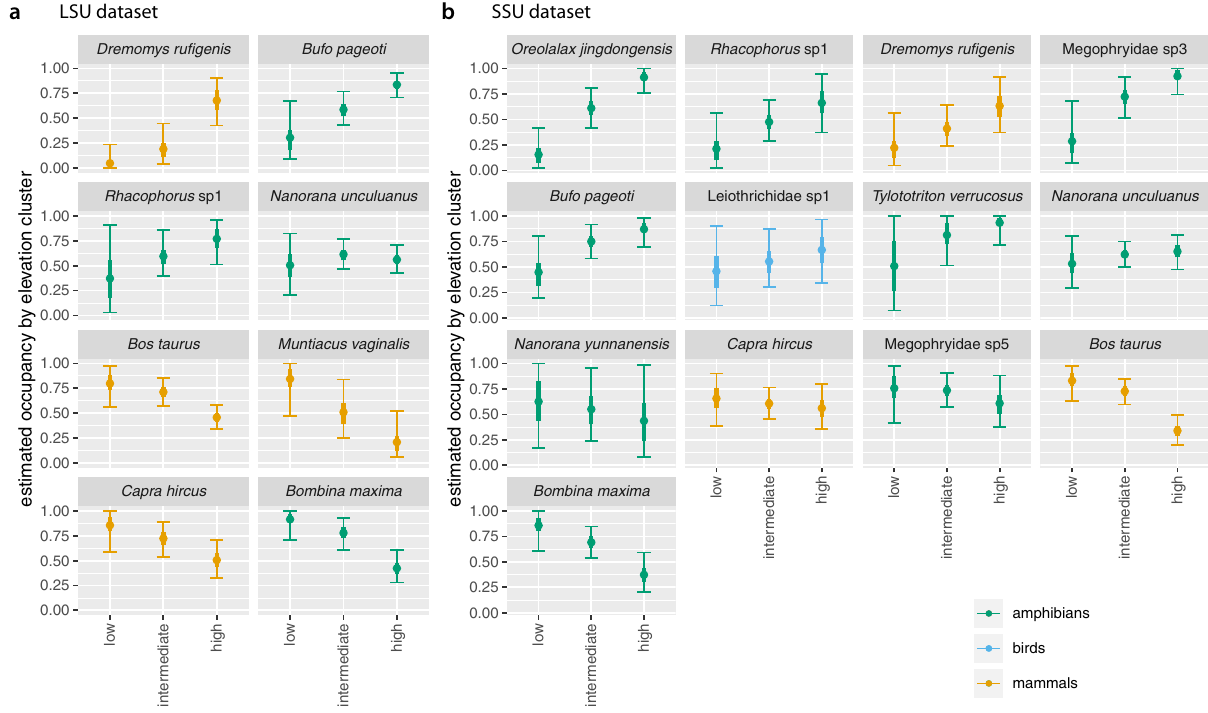
Fig. 6 Occupancy for selected species by site cluster. Estimated occupancy in low-, intermediate- and high-elevation patrol areas for selected species in a the LSU dataset and b the SSU dataset. For each species, fi gure shows posterior mean (dot), interquartile range (thick line) and 95% Bayesian con fi dence interval (BCI; thin line with crossbars) for fraction of sites occupied from models based on n = 893 replicate samples. Patrol areas were divided into low-, intermediate- and high-elevation by clustering based on posterior mean Jaccard distances as shown in Fig. 5 and Supplementary Fig. 8. Species shown are those with posterior mean occupancy ≥ 0.4 and posterior mean detection ≥ 0.1 calculated across all patrol areas. Results for all species are shown in Supplementary Figs. 9 and